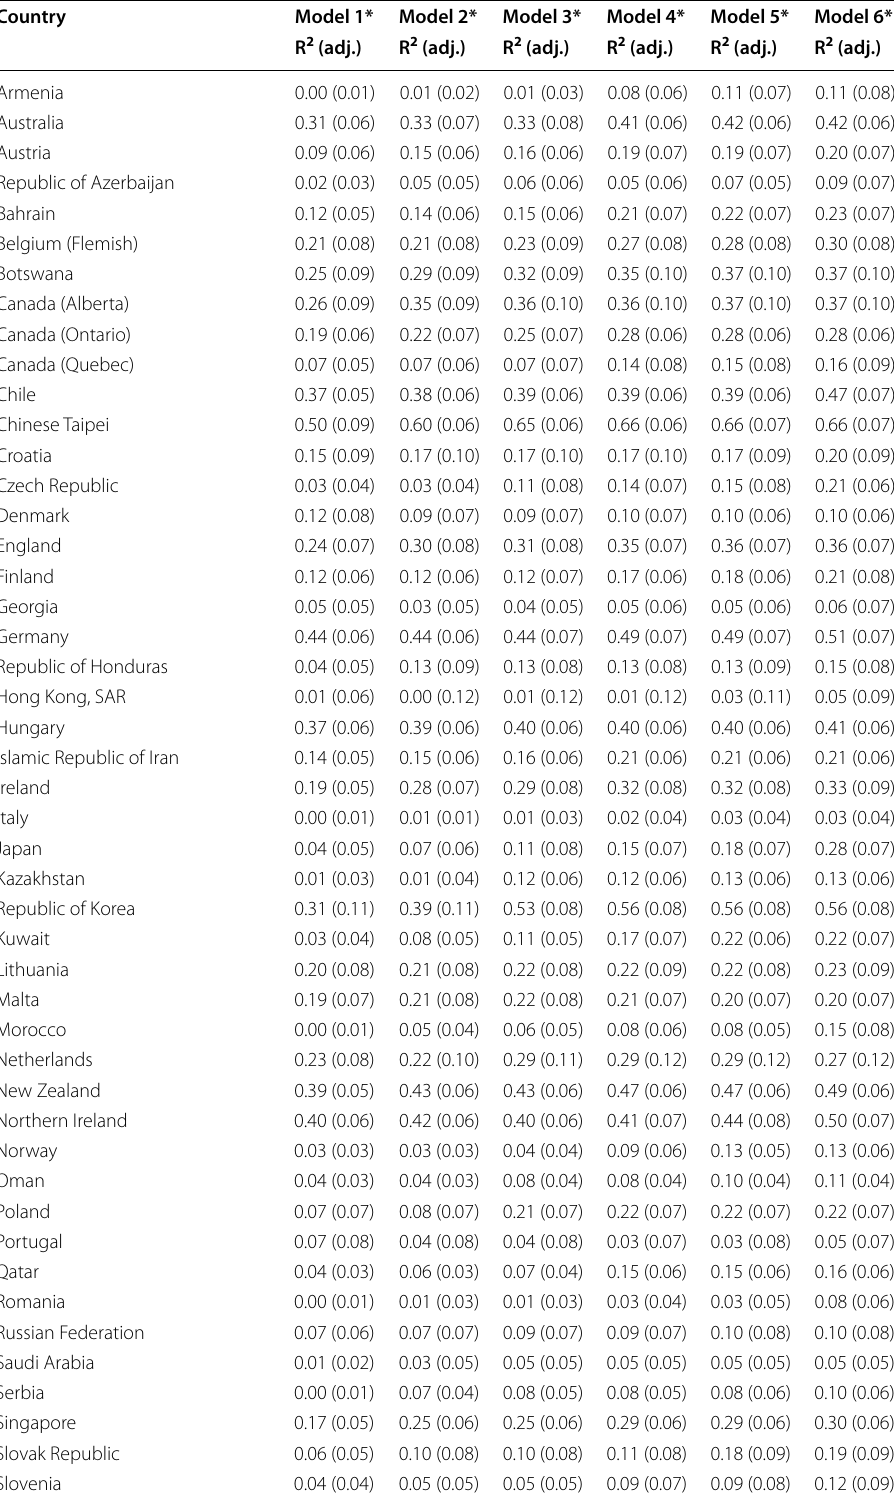
Table 3 TIMSS grade 4—explained variance of school‑averaged mathematics score by model and